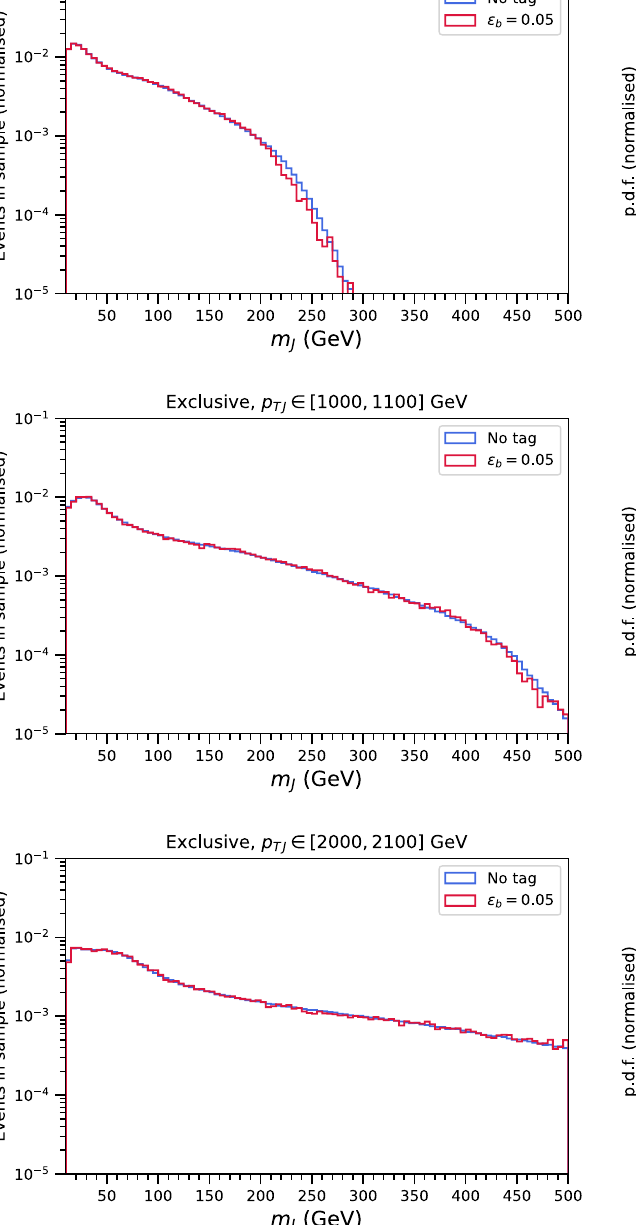
density functions for the estimator T , obtained when the two samples are drawn from the untagged jet pool (yellow) or from the untagged and tagged jet pools (blue)